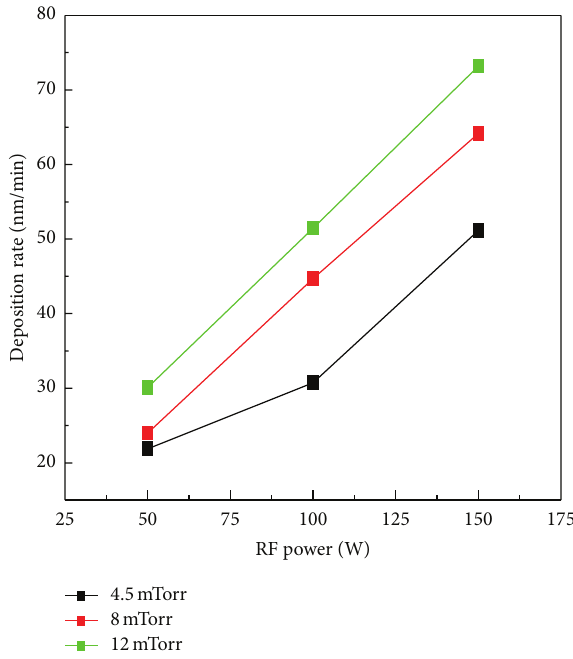
Figure 1: Deposition rates of Mo films prepared at different RF powers and working